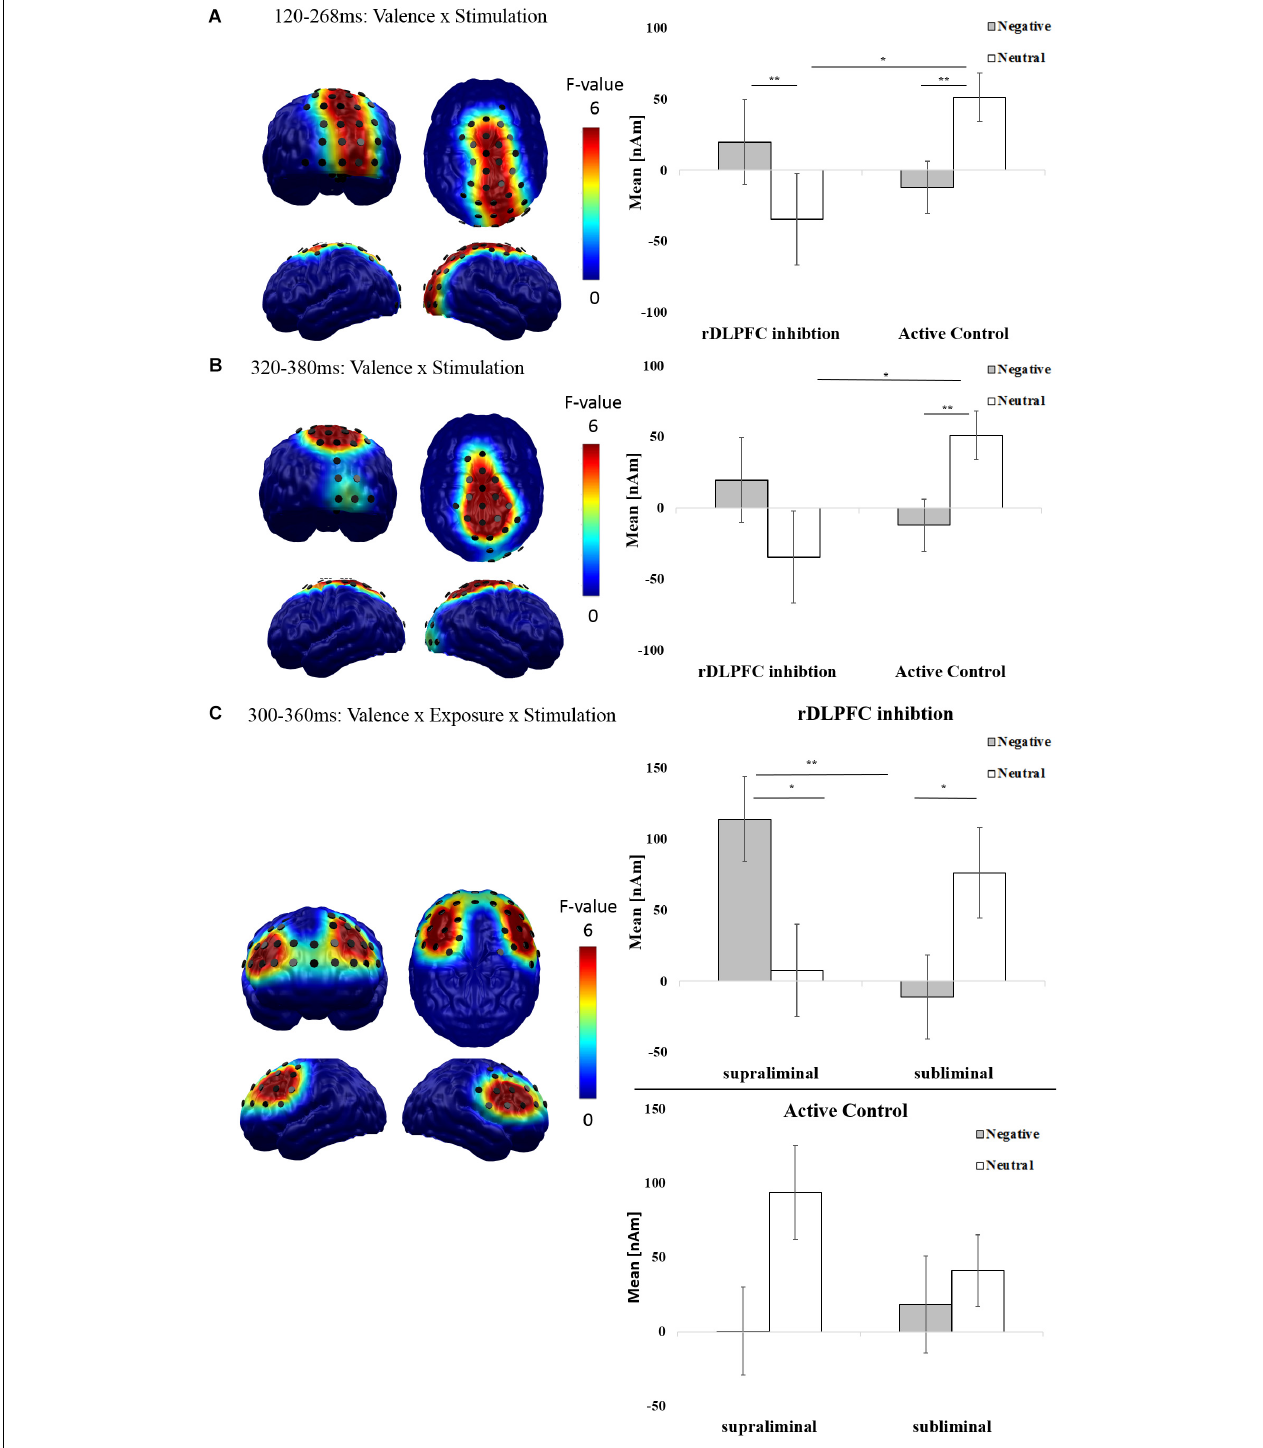
FIGURE 4 | Effects of rDLPFC inhibition on neurophysiological measures of affective processing: The spatial distribution of mean F -values for the (A) mid-latency (120–268 ms) and (B) late (320–380 ms) interaction of valence and stimulation, and (C) for the late (300–360 ms) interaction of valence, stimulation and exposure are displayed for all significant spatiotemporal clusters and masked at a significance level of p < 0.05 (sensor-criterion). Dipoles included in the spatiotemporal cluster ( p < 0.05, corrected) are superimposed in black color. The bar plot depicts the regional mean neural difference activity (Post-cTBS minus Pre-cTBS, in nAm) in the respective spatiotemporal clusters in response to negative (gray) and neutral (white) scenes. Error bars indicate the standard errors of the means. Results of post hoc t -tests for significant interactions (Bonferroni corrected) are indicated ( ∗ p < 0.05, ∗∗ p < 0.01, ∗∗∗ p < 0.001).